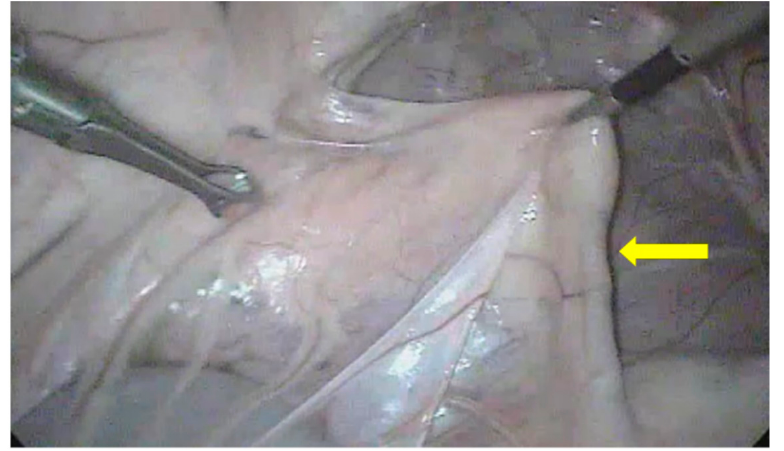
Figure 10 . Omentum (arrow) covering the abdominal organs, making the procedure impossible to perform.